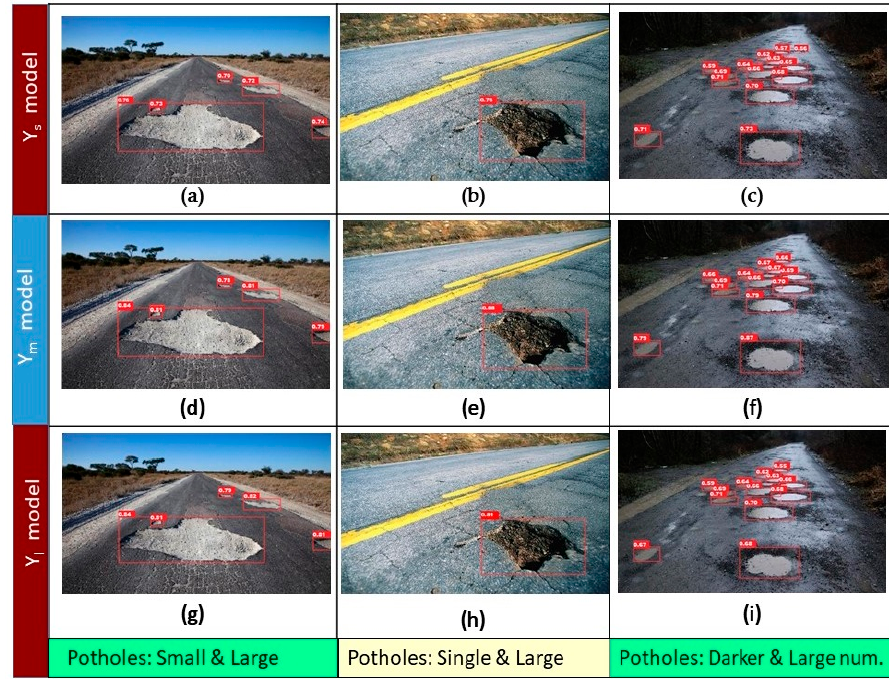
Figure 7. Detection results using YOLOv5: ( a – c ) small; ( d – f ) medium; ( g – i ) large models.